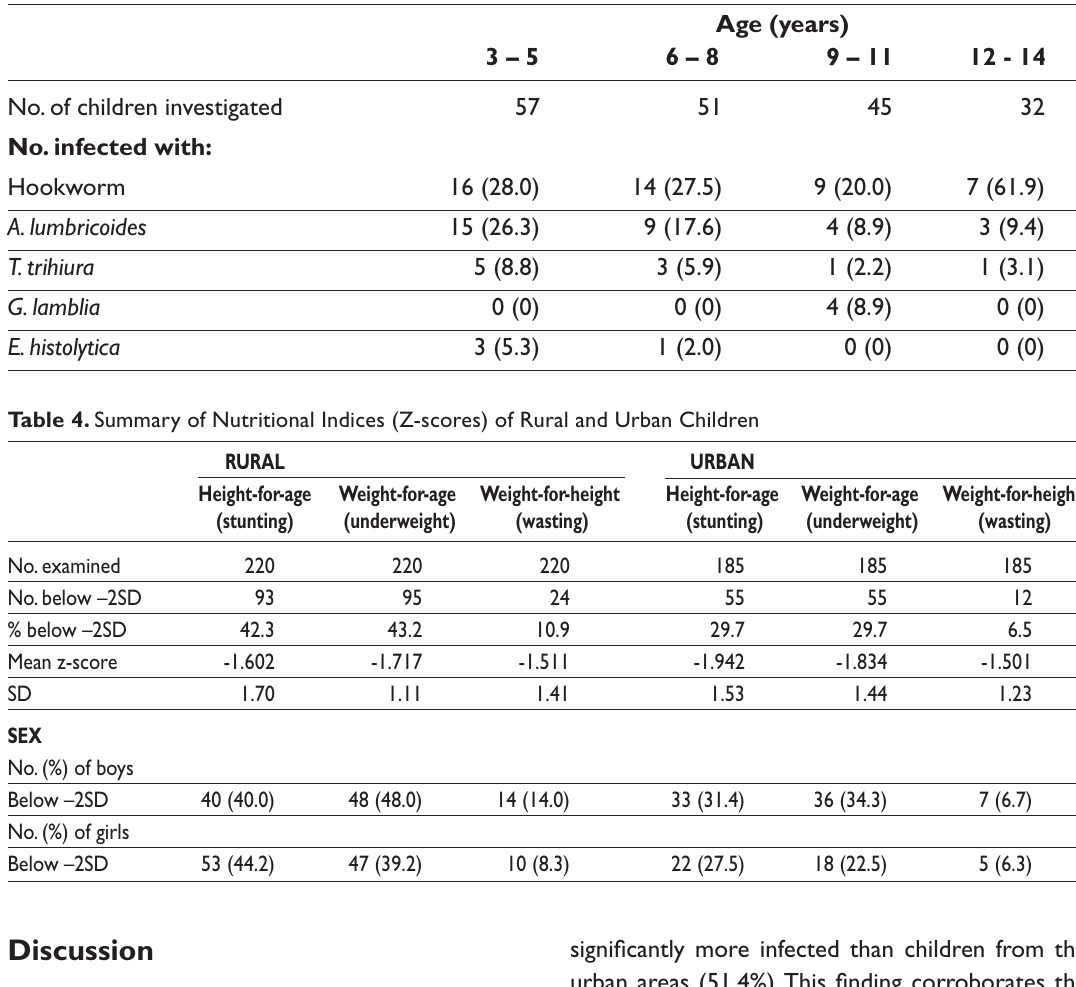
Table 3. The Age-Specific Prevalence of Intestinal Parasite among 185 Urban Children